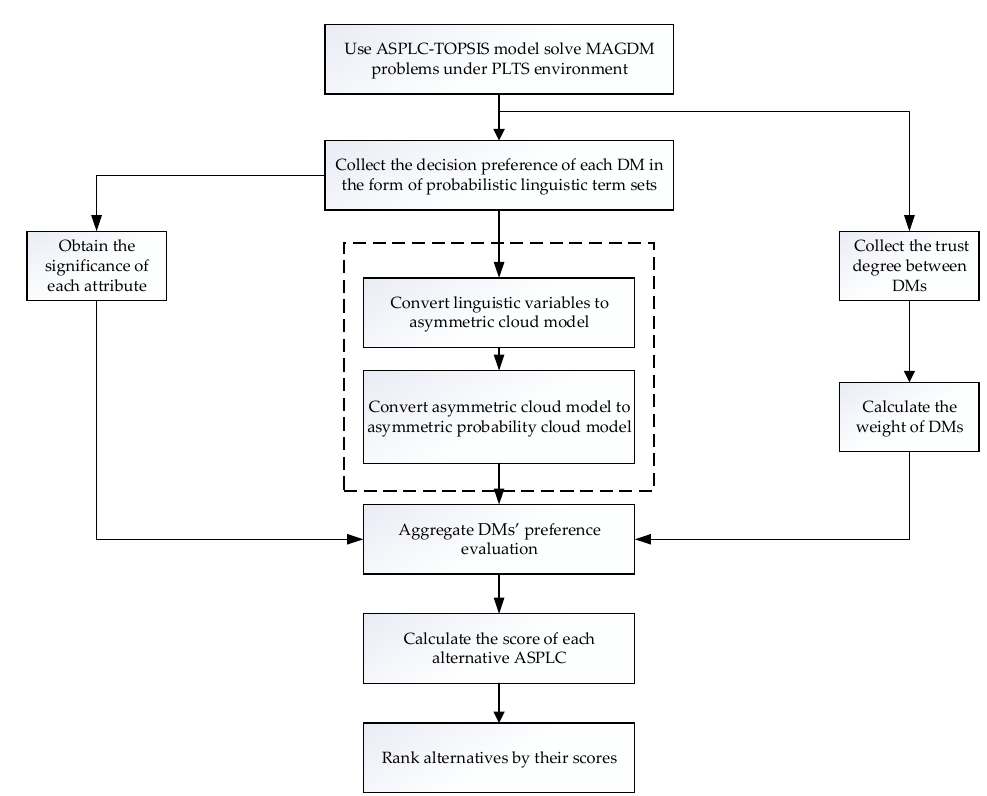
Figure 2. Flowchart of the ASPLC ‐ TOPSIS method procedure.